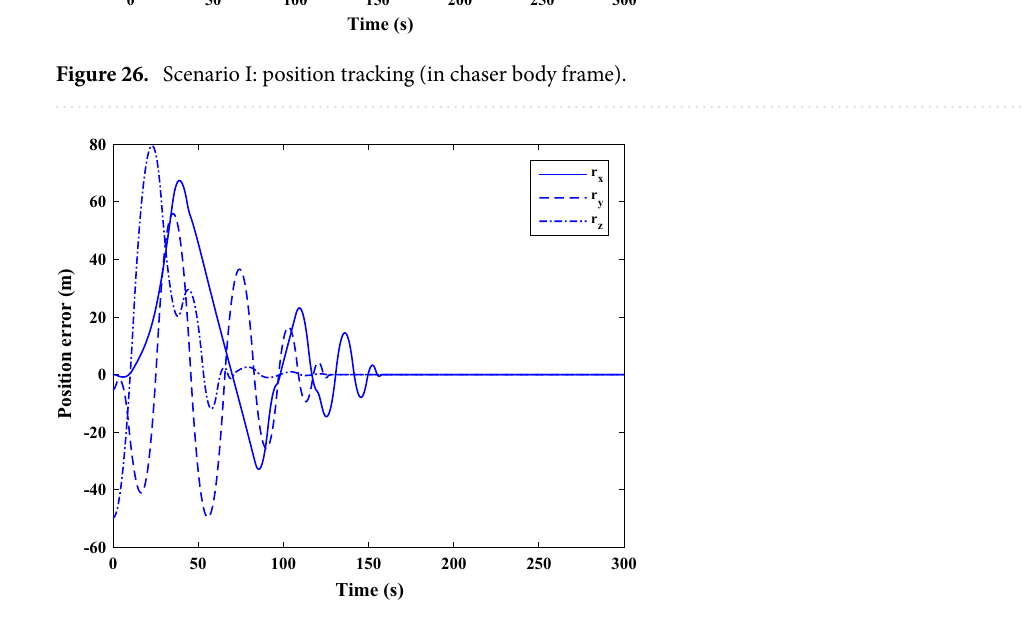
Figure 27. Scenario I: relative position error (in chaser body